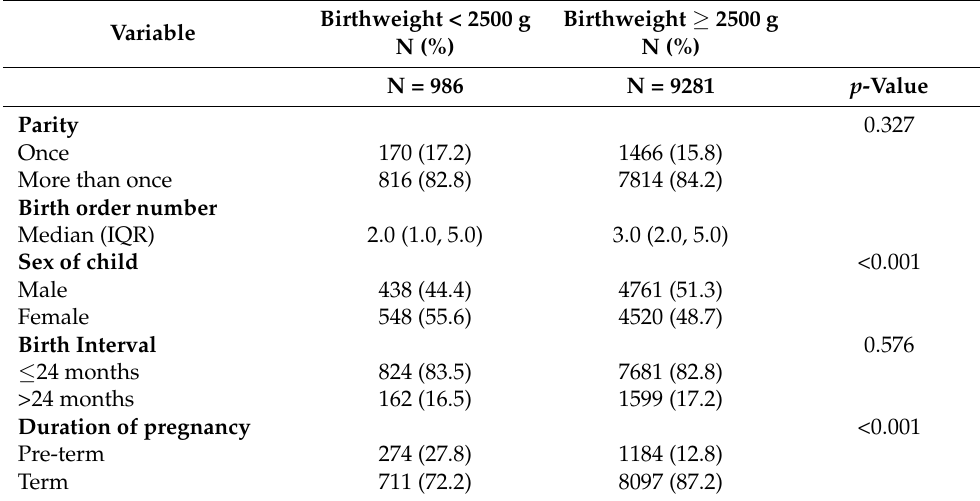
Figure 2. Description of cooking fuel use in rural and urban settings. Other biomass and kerosene = kerosene, charcoal, straw/shrubs/grass, agricultural crop, animal dung. Table 2. Birth characteristics by low birthweight classification of study